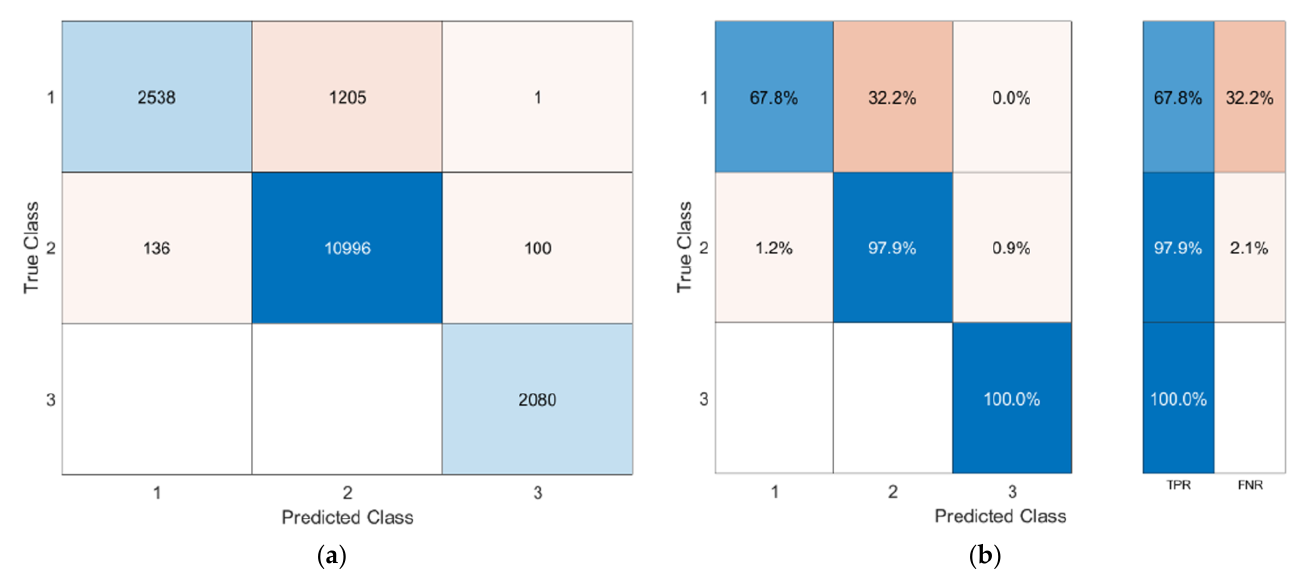
Figure 5. Confusion matrix corresponding to the highest accuracy as shown in Table 5: ( a ) confusion matrix showing numerical values ( b ) TPR and FNR (in percentages).